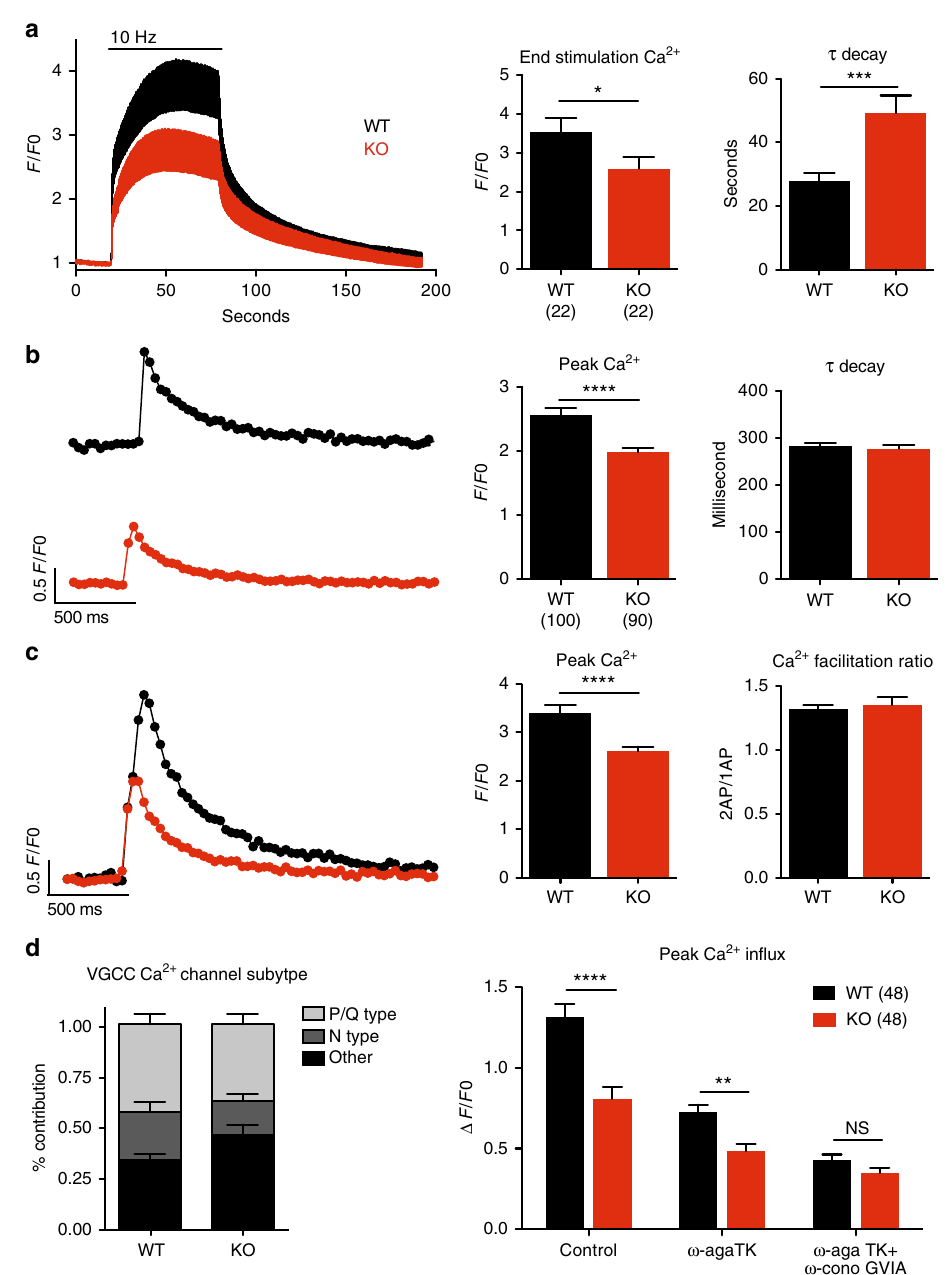
Fig. 6 Reduced calcium in fl ux in the boutons of NHE9 KO mice. a , b Cultured hippocampal neurons were loaded with Fluo5F-AM and stimulated at either 10 Hz for 60 s ( a ) or once ( b ). Left panels show the mean response for all coverslips and the middle panel the mean fl uorescence during the fi nal 10 s of stimulation. The decay for each curve was fi t to a single exponential and the mean time constant for each coverslip plotted in the right panel. Bars indicate mean ± s.e.m. * p < 0.05, *** p < 0.001, and **** p < 0.0001 by unpaired two-tailed Student ’ s t test. n = 22 coverslips/3 cultures/genotype for a and n = 90 – 100 action potentials averaged from 30 boutons/coverslip across 14 – 15 coverslips and 3 cultures/genotype for b . c The same boutons shown in b were stimulated twice at a 50 ms interval. Left panel shows sample traces, middle panel the mean peak fl uorescence, and right panel the ratio of paired to single action potential responses ( b ). Bars indicate mean ± s.e.m. **** p < 0.0001 by unpaired two-tailed Student ’ s t test. n = 90 – 100 responses averaged from 30 boutons/coverslip across 14 – 15 coverslips and 3 cultures/genotype. d Hippocampal neurons were stimulated to produce single action potentials and bouton Ca 2+ entry monitored with Fluo5F in the presence of fi rst ω -Agatoxin TK (300 nM) to block P-/Q-type Ca 2+ channels and then omega Conotoxin GVIA (1 μ M) to block N-type channels as well. NHE9 KO neurons show less presynaptic Ca 2+ entry through P-/Q- and N-type channels than WT neurons (right panel). Left panel depicts the contribution of each Ca 2+ channel subtype to the total response. Bars indicate mean ± s.e.m. **** p < 0.0001, ** p < 0.01 by paired two-way ANOVA. n = 48 paired action potentials averaged from 30 boutons/coverslip across 12 coverslips and 3